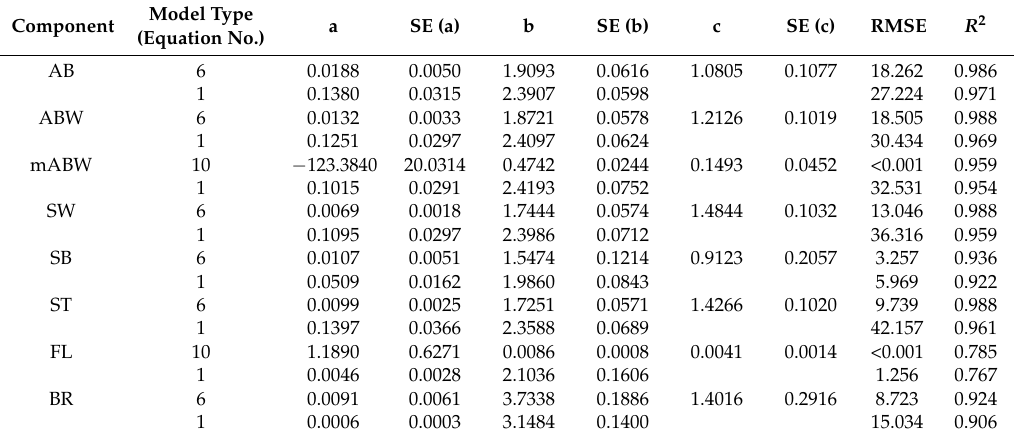
Table 3. Generalized allometric models for tree biomass for all sample trees ( n = 96). For each biomass component we provide the best fit model based on both tree height and diameters at breast height (DBH) as well as on DBH only.